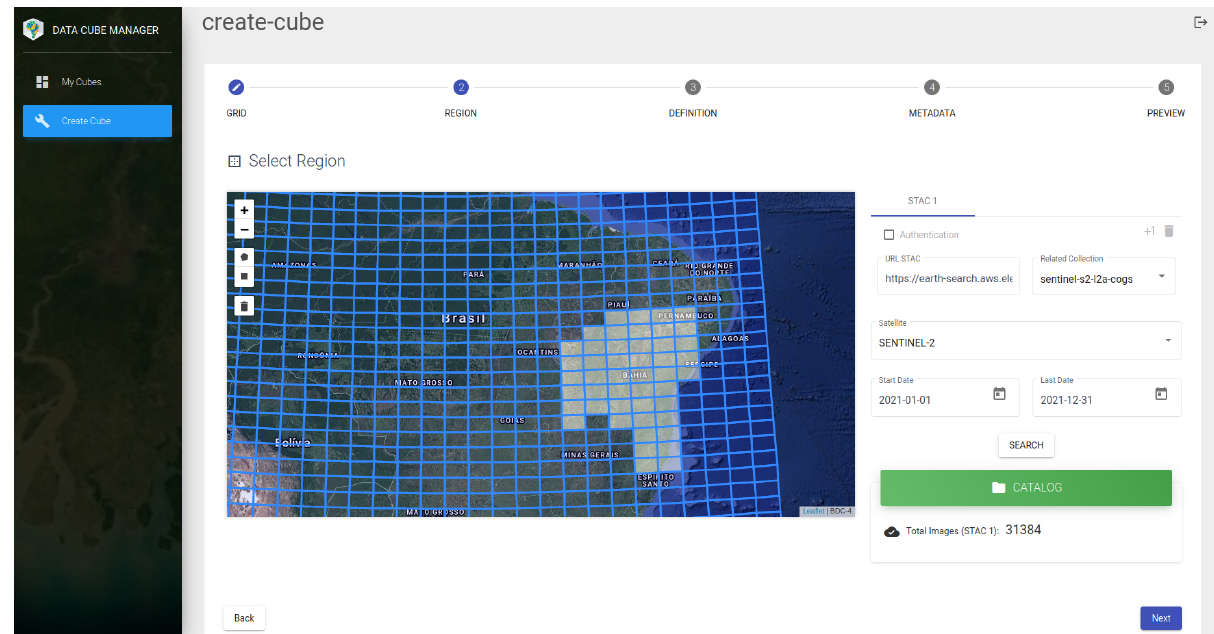
Figure 5. Architecture of Data Cube Builder on AWS.